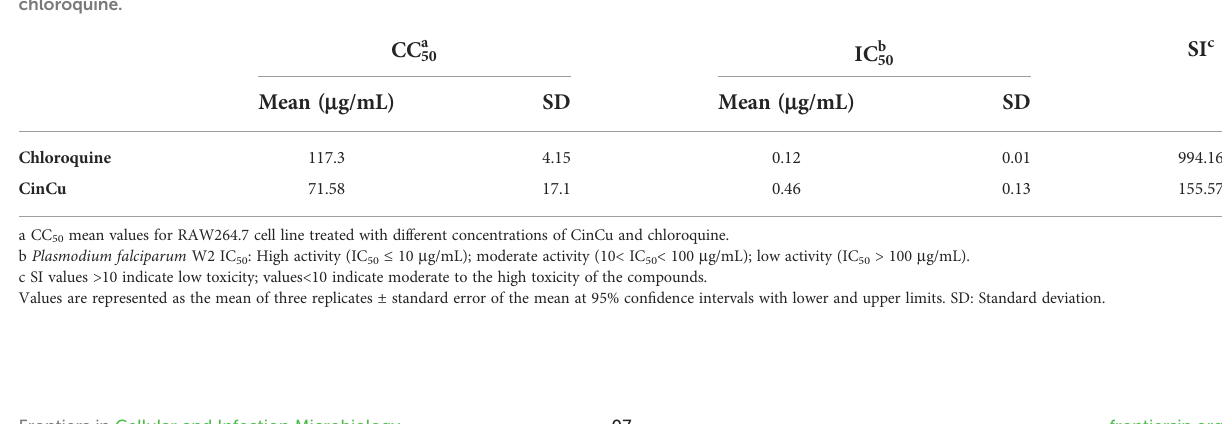
TABLE 1 In vitro analysis of antiplasmodial and cytotoxicity activity of Bis[Cinchoninium Tetrachlorocuprate(II)]trihydrate (CinCu) and chloroquine.